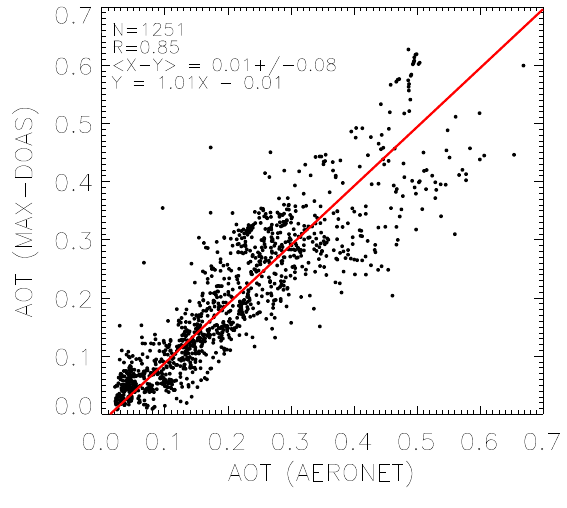
Fig. 14. Comparison between AOT derived from MAX-DOAS relative intensity observations in De Bilt and AERONET AOT (Cabauw). Both sites were 22 km apart. The selection criteria described in Sect. 4.3 were applied to all measurements in the observation period (see Sect. 2.2). The red line represents a linear regression, where the squared orthogonal distance of all points to the 1:1 line was minimized.